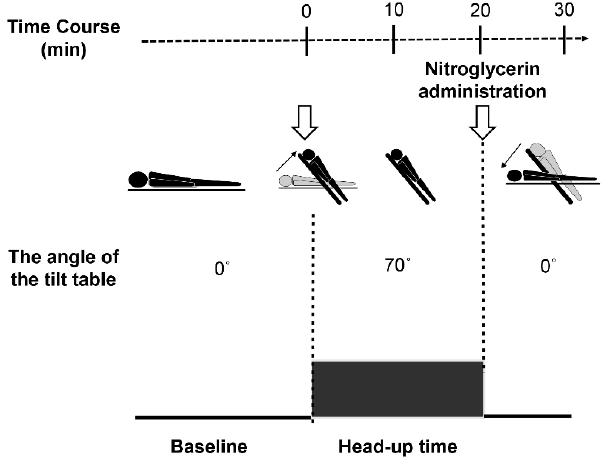
Figure 1. HUTT protocol.